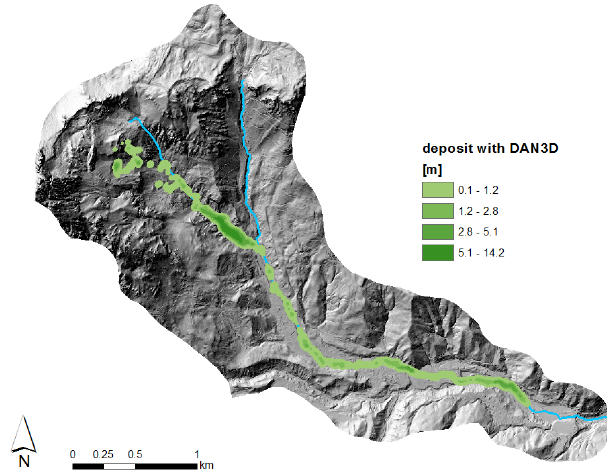
Figure 4. Volumetric and areal distribution of the morphologic vari- ations that occurred between October and November 2010. The de- position is in blue, erosion is in red and the values discarded for the volumetric assessment are in grey.